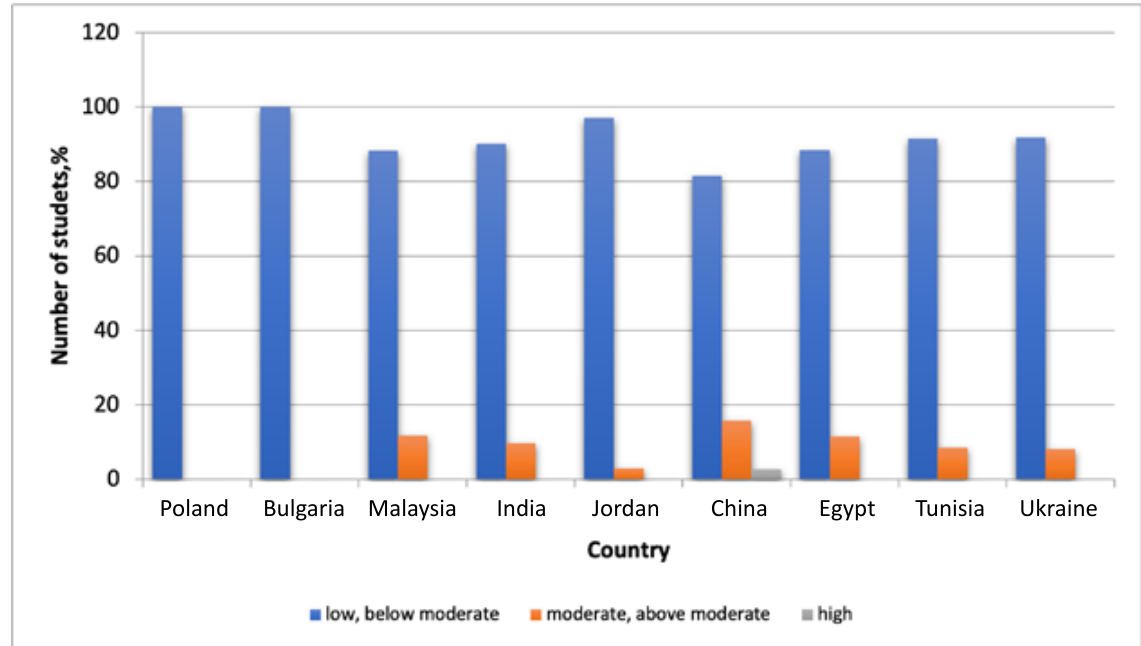
Figure 7. Distribution of students by Level of physical condition (PCL,